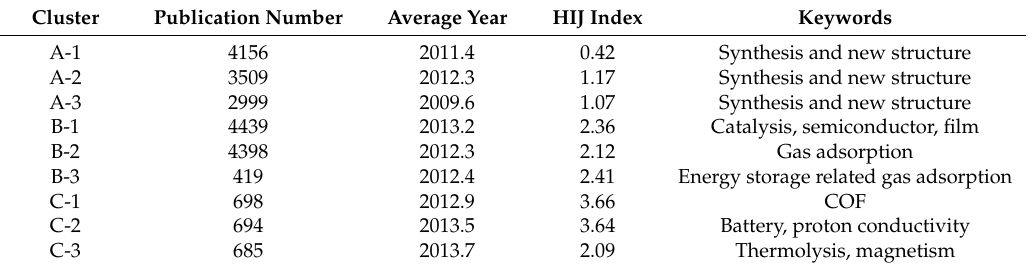
Table 2. High impact areas of research for